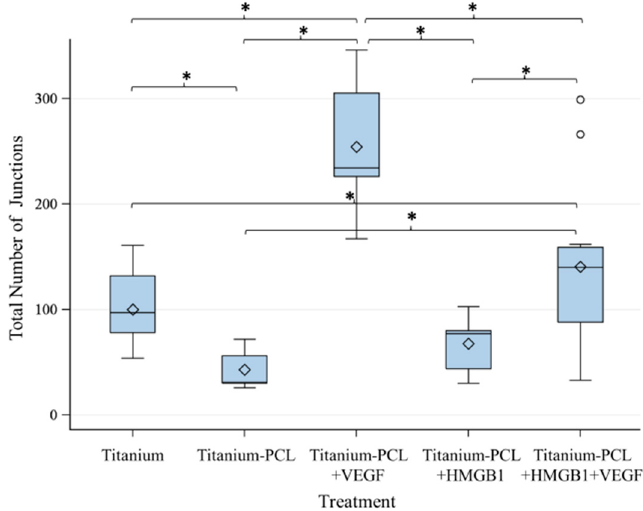
Figure 4. Number of Junctions built due to the investigated implant. VEGF-functionalized titanium-PCL implants showed significantly more junctions than all of the other implants. VEGF +